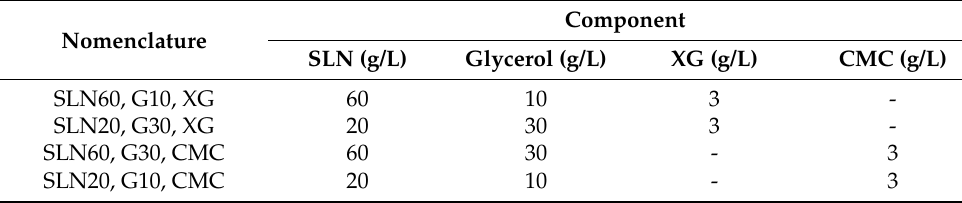
Table 1. Components used in the formation of the